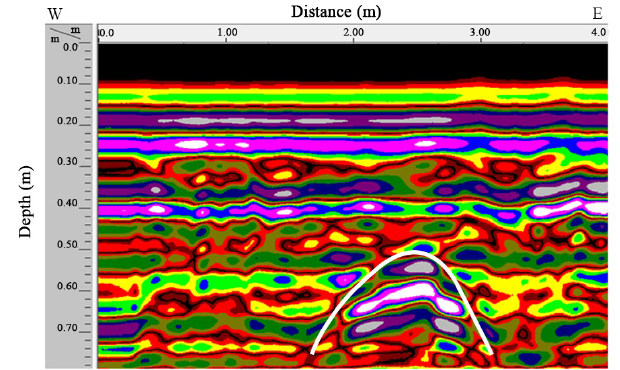
Figure 6. A 900MHz antenna radargram along Profile 9002. The white rectangle along the radargram at approximate depth of 0.20m may correspond to buried wall. The 4m wide depression at end of the profile may be correlated to buried channel.